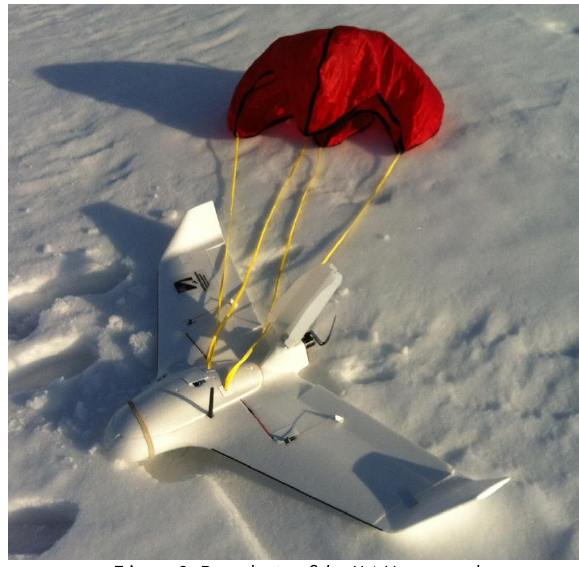
Figure 3. Parachute of the UAV